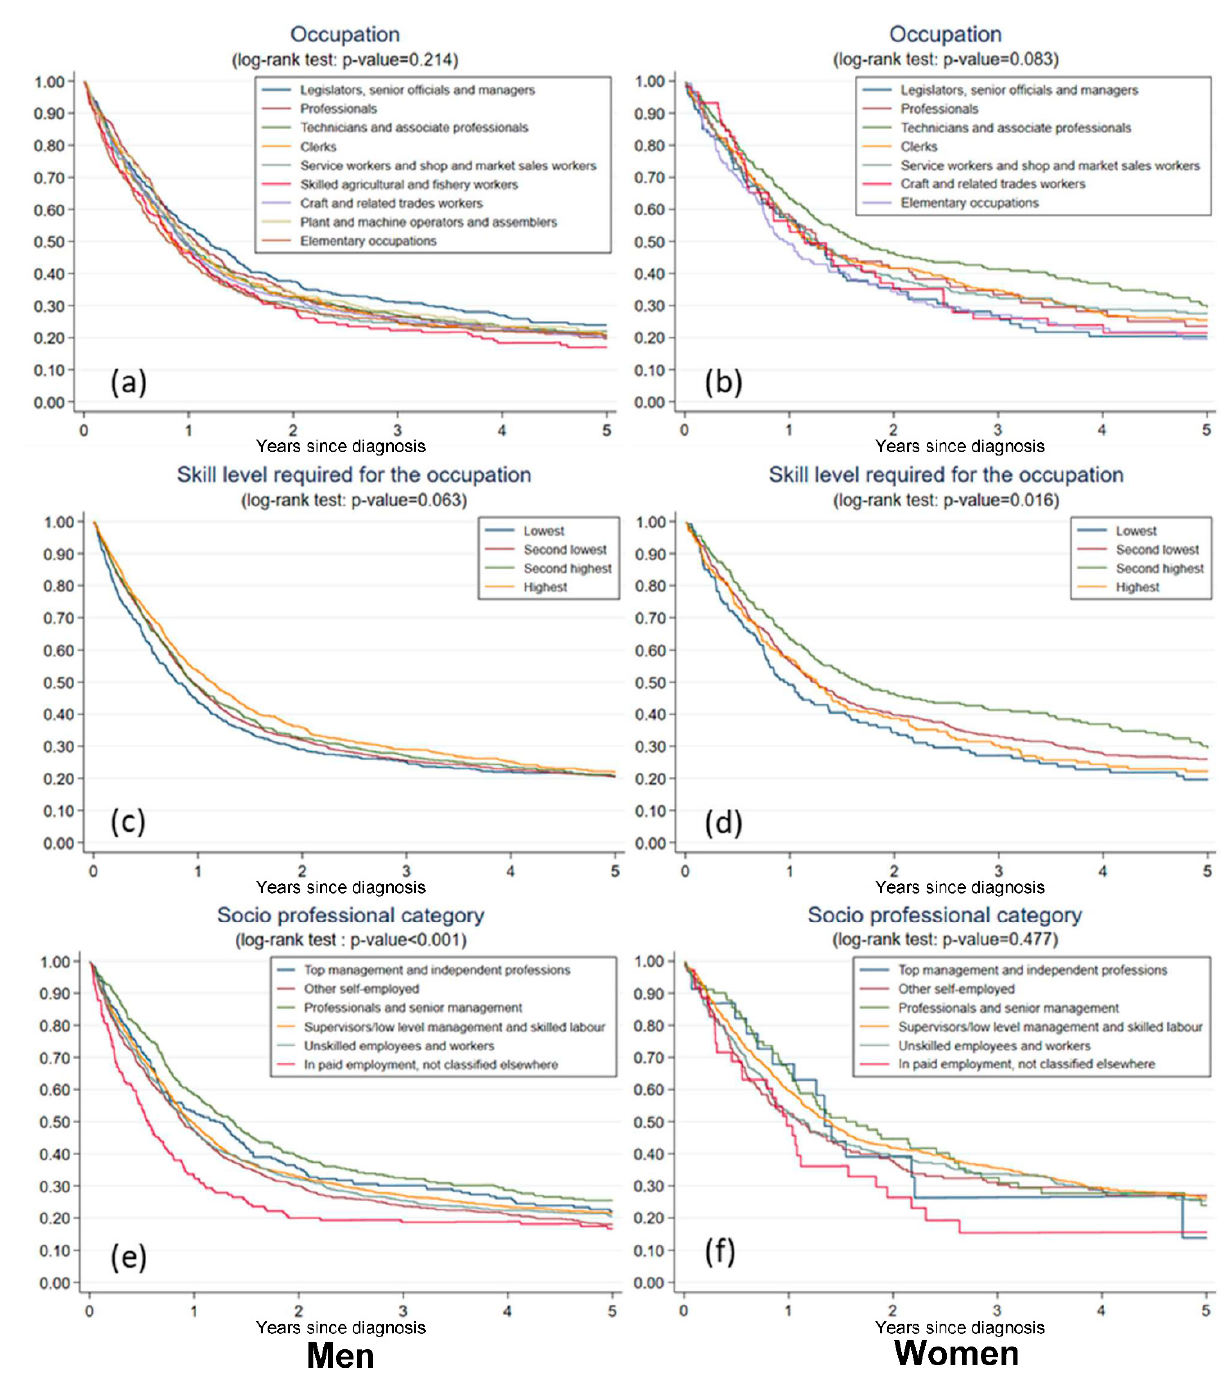
Figure 1. Nonparametric five-year net survival of lung cancer in men and women across ( a , b ) occupation, ( c , d ) skill level required for the occupation, and ( e , f ) socio-professional category.